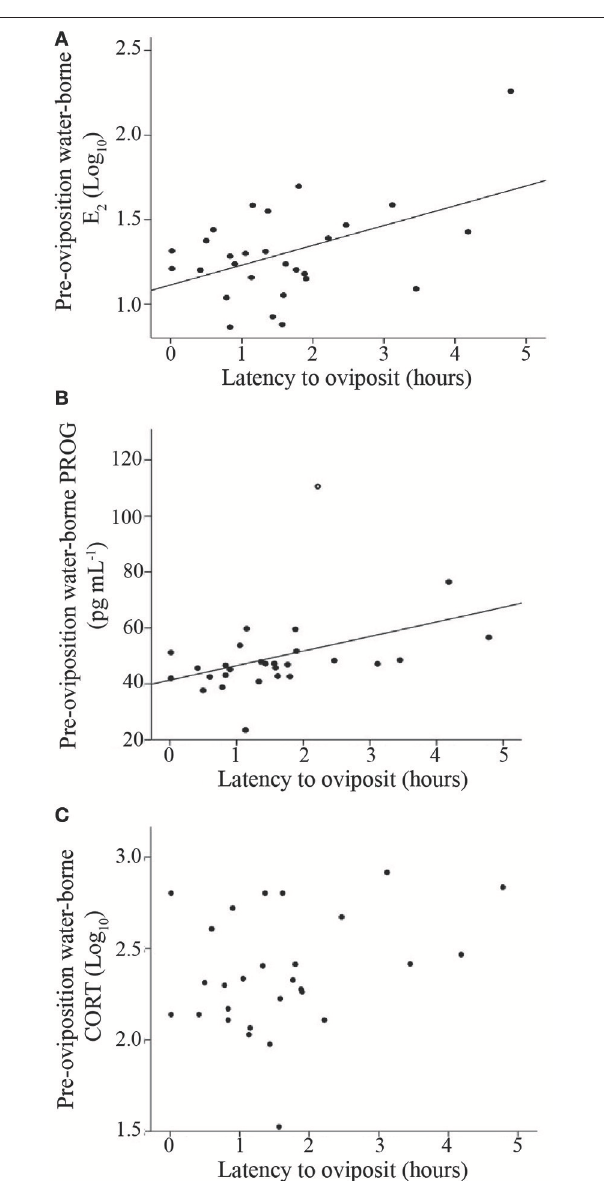
FIGURE 3 | Scatterplot illustrating the relationships between latency to oviposition and pre-oviposition water-borne (A) estradiol (E 2 ) (B) progesterone (PROG), and (C) corticosterone (CORT). E 2 and CORT were log 10 transformed. Solid lines indicate a significant correlation ( p < 0.05). Open circle in (B) indicates a statistical outlier, the removal of which does not change the significance of the